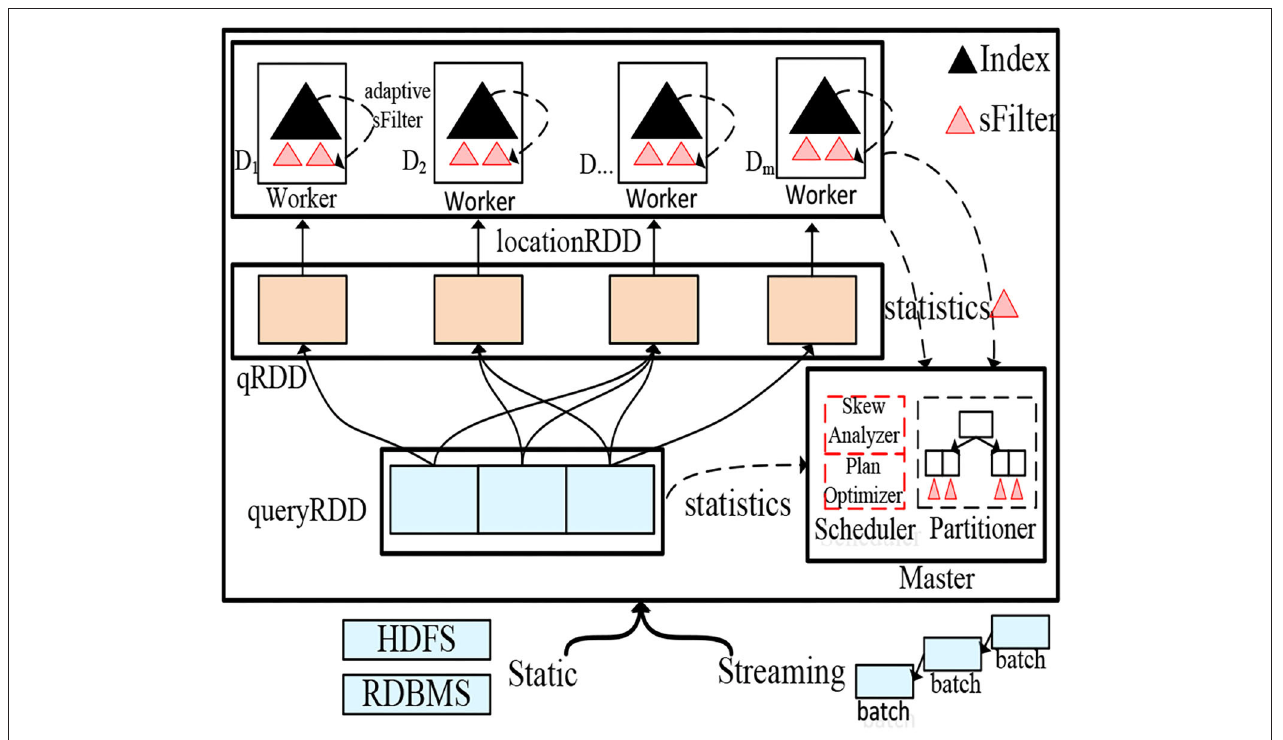
FIGURE 2 | LOCATIONSPARK System